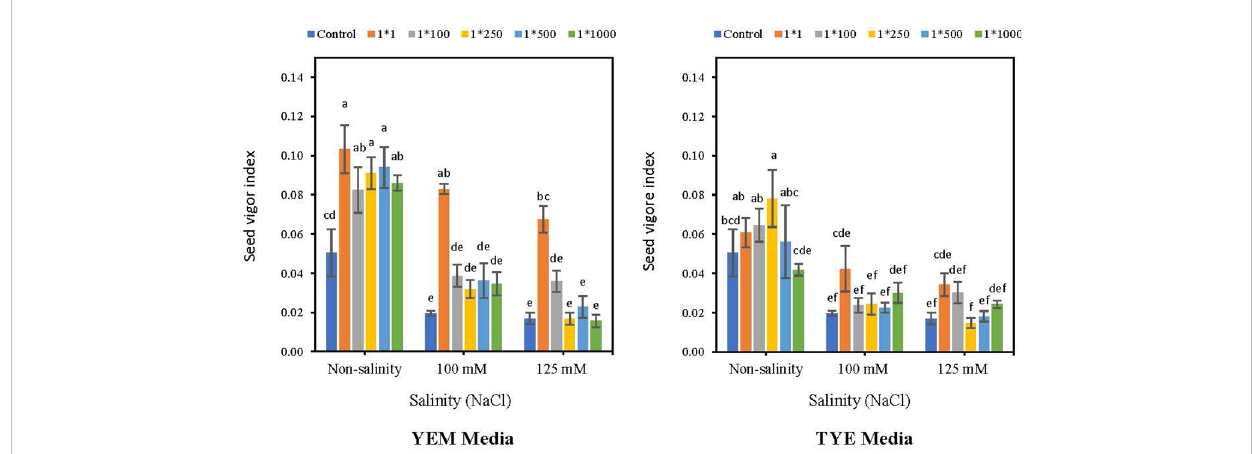
FIGURE 9 Effect of dilutions of Devosia sp. YEM(B)-CFS and TYE(B)-CFS and salinity on seed vigor index of soybean seedlings. Values represent the mean of four replicates ± SD. 1:1, 1:100, 1:250, 1:500 and 1:1000 = 1 mL Devosia sp. CFS and 1, 100, 250, 500 and 1000 mL distilled water,